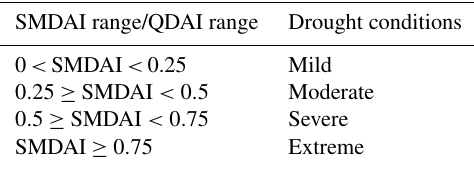
Table 2. SMDAI and QDAI range corresponding to drought